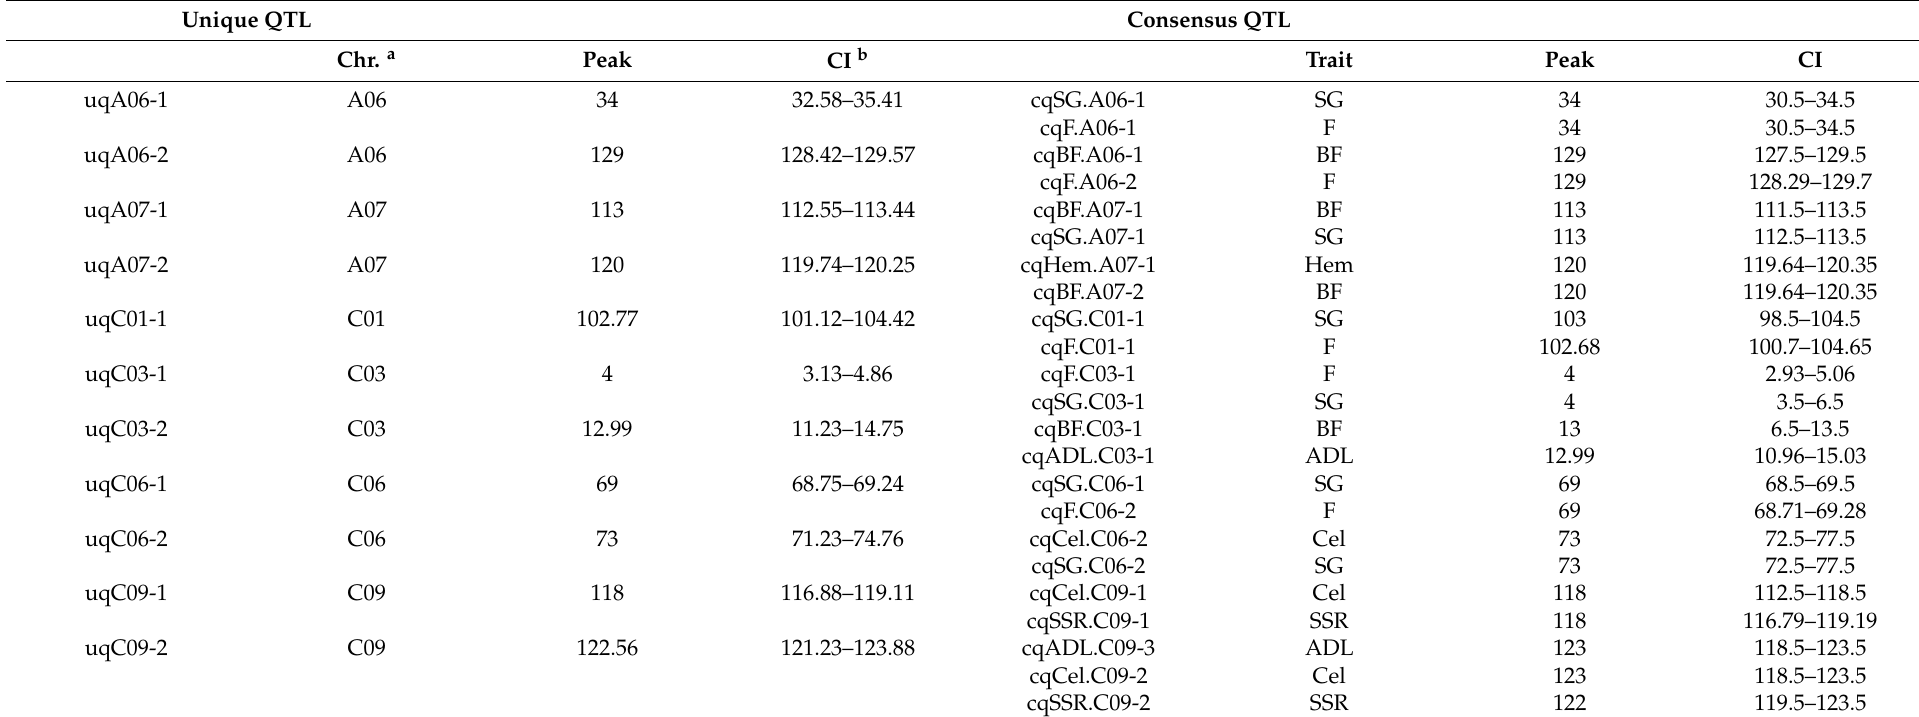
Table 3. Unique QTL information involved in more than two traits in this